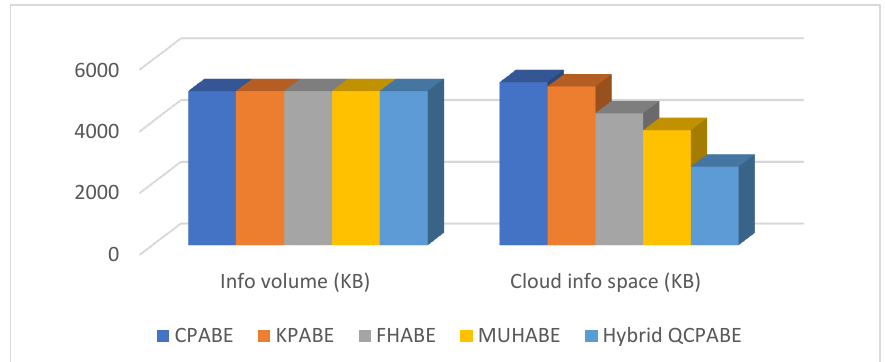
the proposed standard with respect to conventional ABE standards.